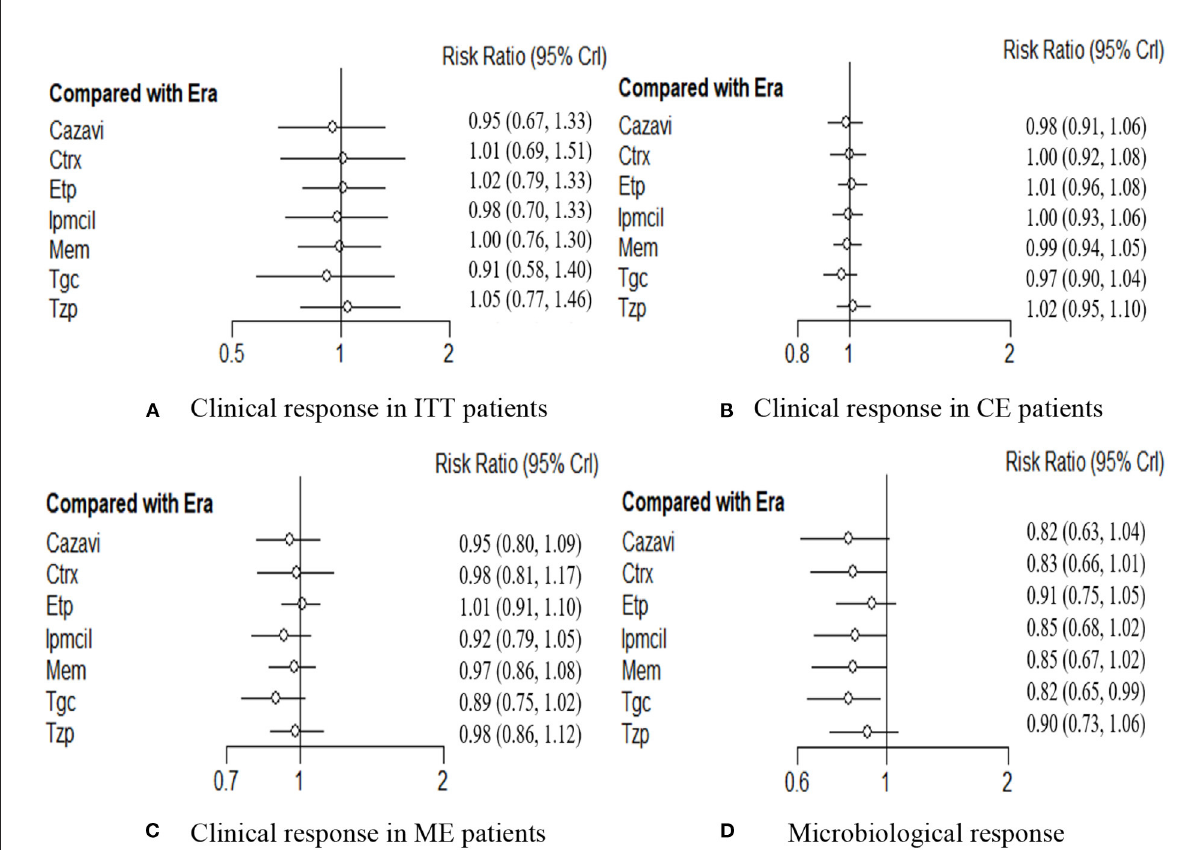
FIGURE4 (A–D) Forest plot for efficacy endpoints. ITT, intention-to-treat; CE, clinical evaluate; ME, microbiological evaluable; Era, eravacycline; Etp, ertapenem; Mem, meropenem; Tgc, tigecycline; Cazavi, ceftazidime/avibactam + metronidazole; Tzp, piperacillin/tazobactam; Ctrx, ceftriaxone + metronidazole; Ipmcil,